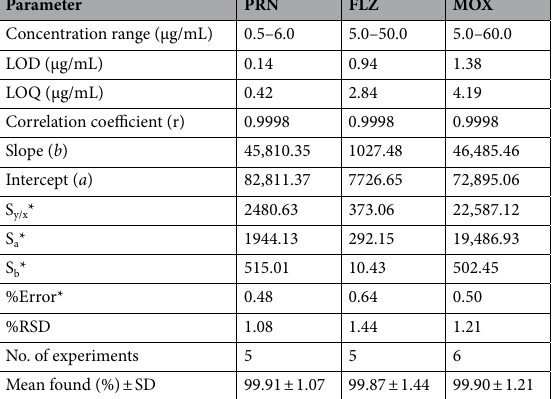
Table 2. Analytical performance data for the determination of the studied drugs by the proposed HILIC method. *N.B. S y/x = standard deviation of the residuals. S a = standard deviation of the intercept of regression line. S b = standard deviation of the slope of regression line. % Error = RSD%/√